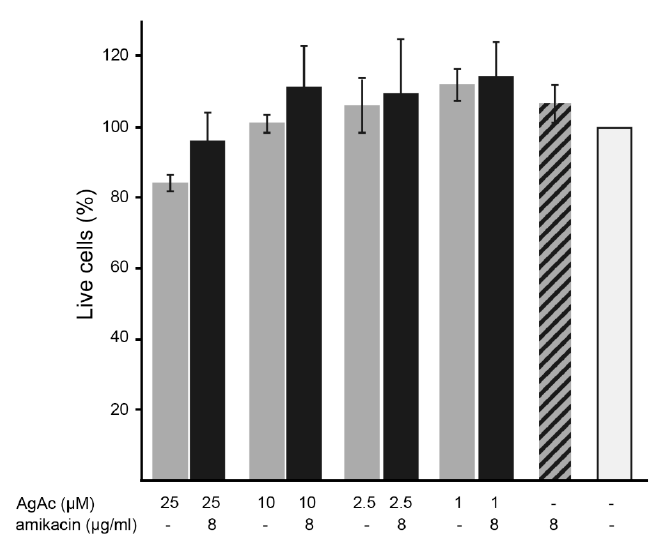
Figure 4. Cytotoxicity of silver acetate (AgAc) and amikacin. Cytotoxicity of silver acetate alone and in combination with amikacin on HEK293 cells was assayed using a LIVE/DEAD kit. The percentage of surviving cells was calculated relative to cells untreated (white bar). Cells incubated with 70% methanol were used as a control of maximum toxicity (striped bar). The experiments were conducted in triplicate and the values are mean ±